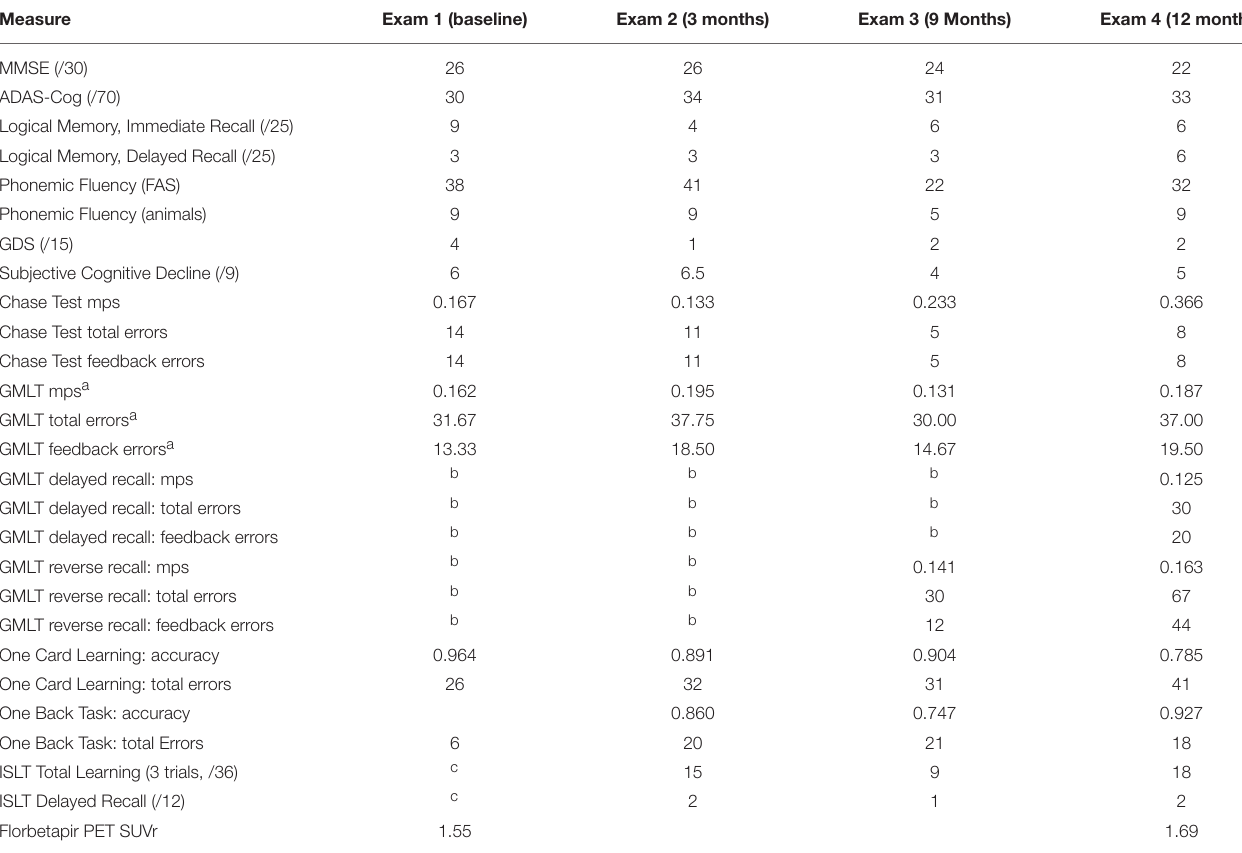
TABLE 2 | Scores on all outcome measures for patient CS, age 74, over 12 month DFMO treatment period.